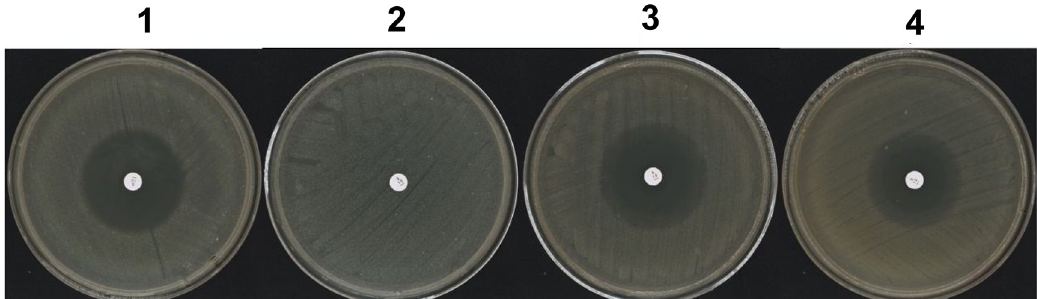
Fig 2. Antimicrobial susceptibility test using the disk diffusion method. Y . pestis strains were streaked on cation-adjusted Mueller-Hinton agar plates with streptomycin disc (300 μ g/disc), incubated plates at 35˚Cfor 48 h. 1: Y . pestis vaccine strain EV76 (Vaccine strain, MIC: 4 mg/L); 2: Y . pestis S19960127 ( rpsL-128G , MIC 4,096 mg/L); 3: Y . pestis S19960127:: rpsL-128A (MIC 4 mg/ L); 4: Escherichia coli ATCC